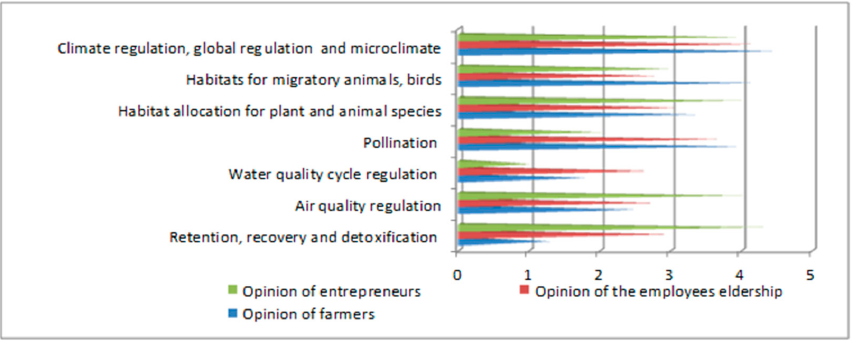
Figure 3. Respondents’ views on the future (2020–2030) potential of regulation and maintenance ES, in score average.